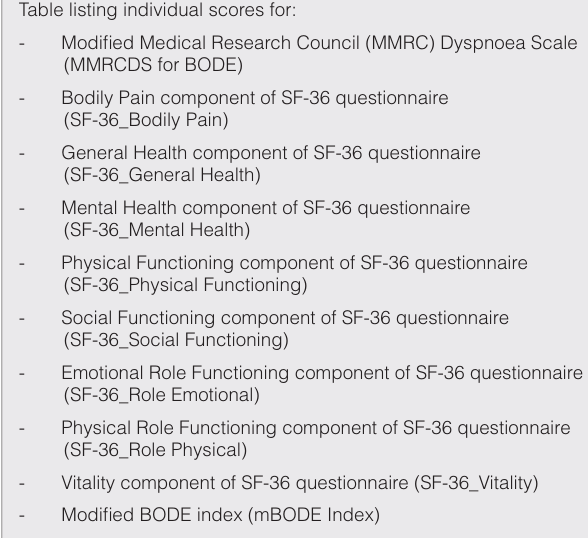
Table listing individual scores